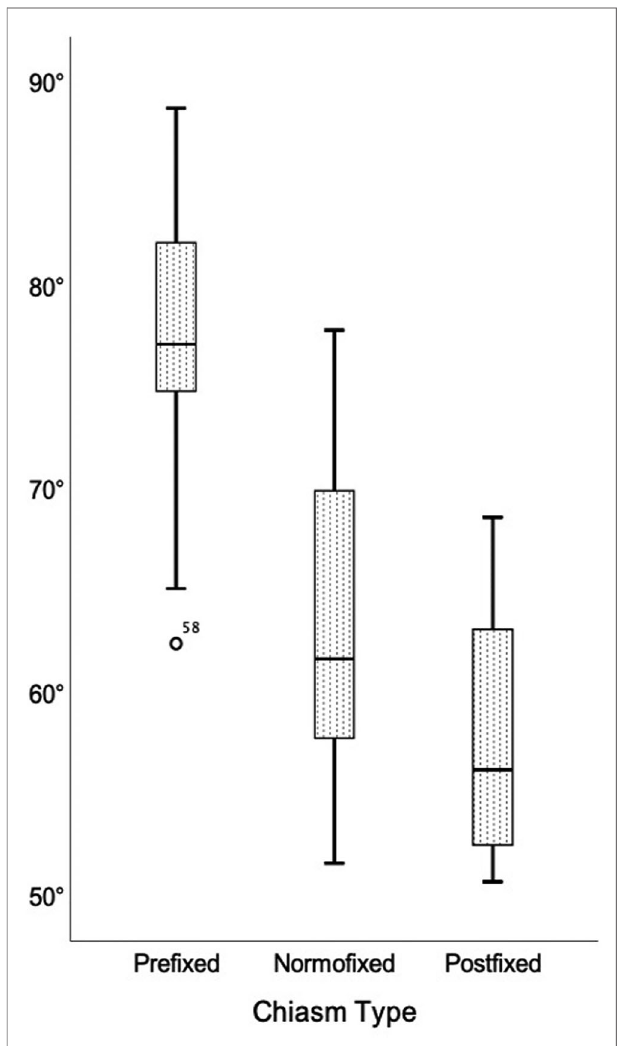
FIGURE 7 | Comparison of the interneural angle in pre fi xed, normo fi xed, and post fi xed optic chiasm types.